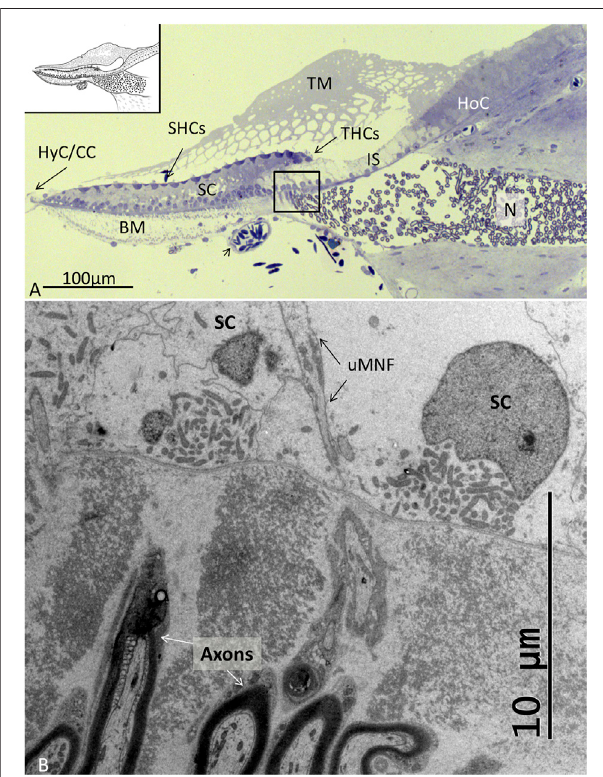
FIGURE3|(A) .Light microscopy oftheabneural region (left inset)ofthe papilla believed to be a regenerative zone. SCs in this region are often vacuolated (staple), and cell projections connect to the sensory cells (arrow). SC nucleiare basallylocated.Attheborder (*), there are HyCsand cubic cells (CCs) that are innervated (right inset). BM: basilar membrane, SHCs: short hair cells, BL: basal lamina. (B) . Neural region with THCs and the habenula perforata with entering neurons (N). The TM appears to be secreted from the HoCs with clear endolymph at the inner sulcus (IS).